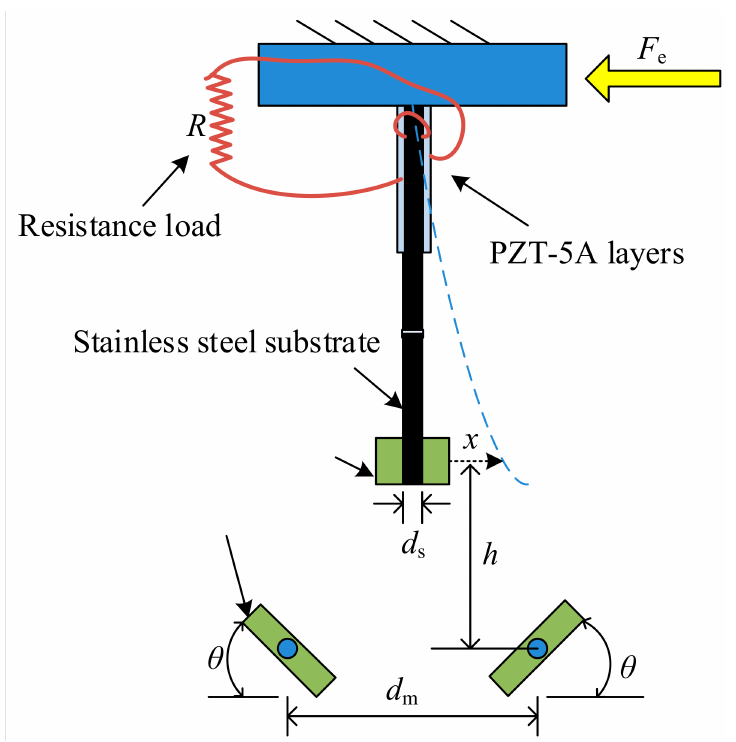
Figure 19. The nonlinear energy harvester with external magnets of variable inclination